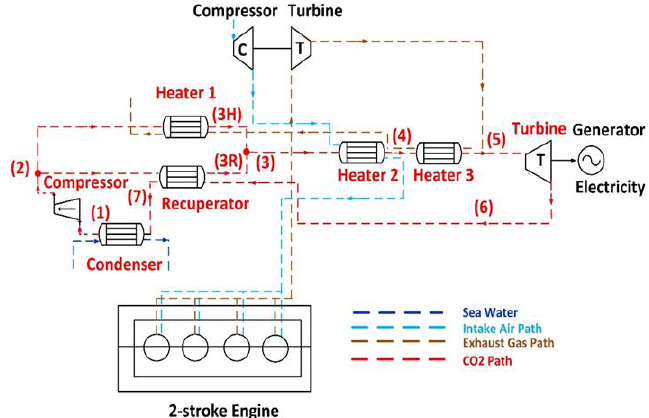
Figure 4. Schematic view of the split supercritical CO 2 cycle.